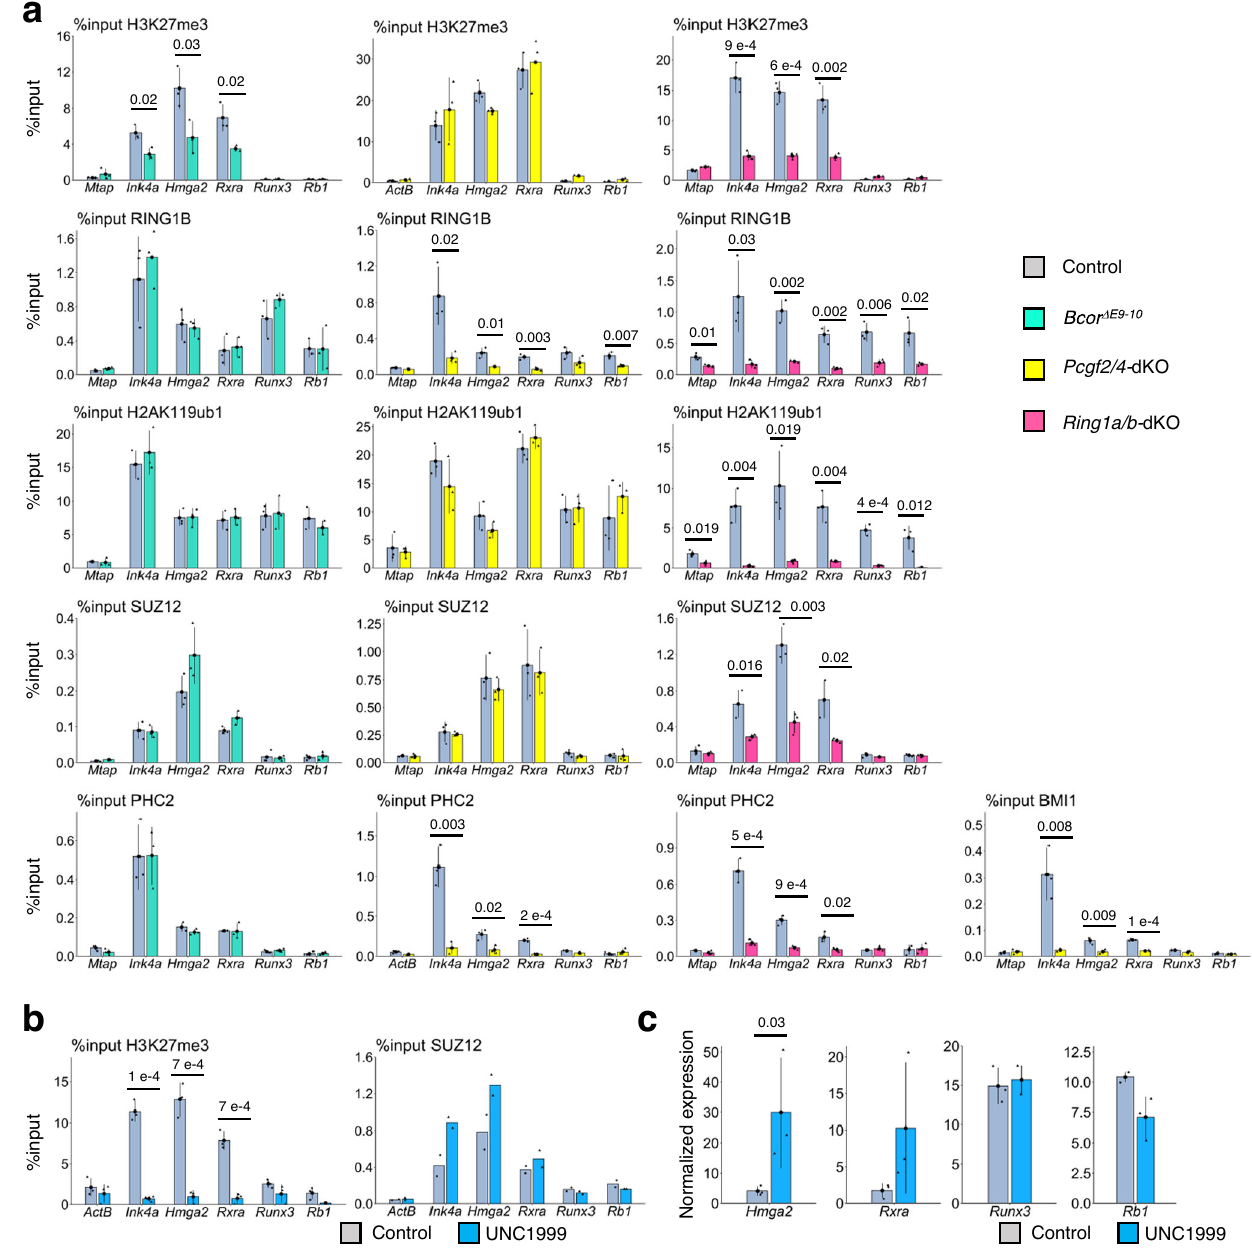
Fig. 4 | PCGF1maintains H3K27me3 mediateddown-regulationoftarget genes as a component of the PCGF1-PRC1. a Destabilization of H3K27me3 mark in Bcor Δ E9-10 and Ring1a/b -dKOIdHPCsbutnotin Pcgf2 /4-dKO.ChIP-qPCRanalysesfor localbindingofRING1B,H3K27me3,andH2AK119ub1atselectedC1andC2genesin the control and Bcor Δ E9-10 , Pcgf2 /4-dKO and Ring1a/b -dKO IdHPCs are shown. Data representmean±SDofthreeindependentexperiments.Thenumbersonthegraph are p -values between the control and respective mutants calculated with the Stu- dent ’ s two-sided t test. b , c H3K27me3 at the C1 promoters contribute down-